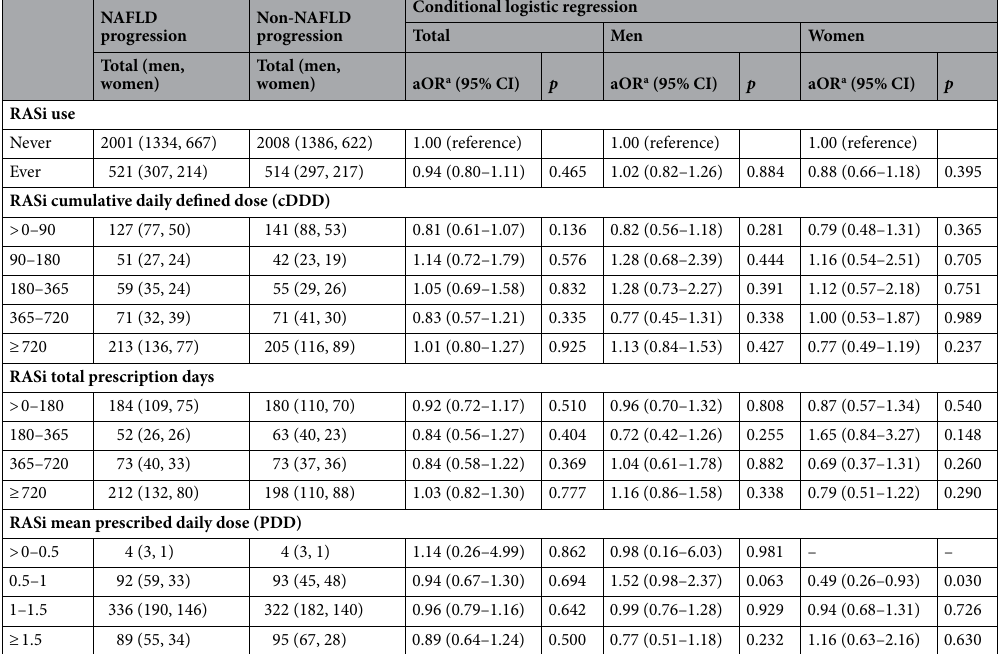
Table 3. Risk of NAFLD progression according to the RASi exposures. a Adjusted for age, body mass index, waist circumference, fasting plasma glucose, α-glucosidase inhibitor, β-blocker, metformin, sulfonylurea, thiazolidinedione, Charlson comorbidity index score, diabetes, hypertension. CI confidence interval, NAFLD non-alcoholic fatty liver disease, OR odds ratio, RASi renin–angiotensin–aldosterone system